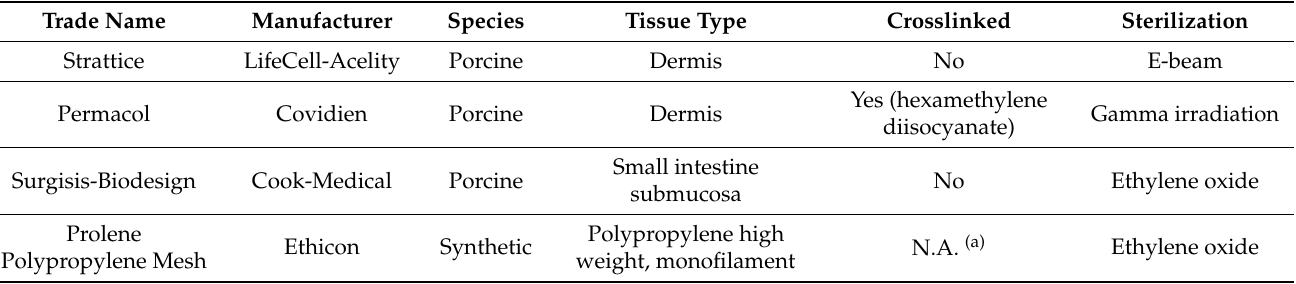
Table 1. Description of matrices used in this